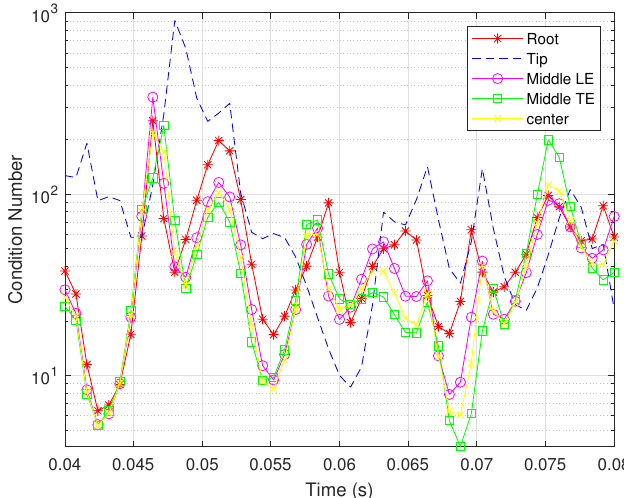
Figure 14. Condition numbers for bending strain sensors located in different places. When the sensors are assumed to be inaccurate, the noise variances of the shear and bending strain sensors are 1 × 10 − 18 and 1 × 10 − 19 , respectively; the interference binary values from noisy measurements are shown in Figures 15 and